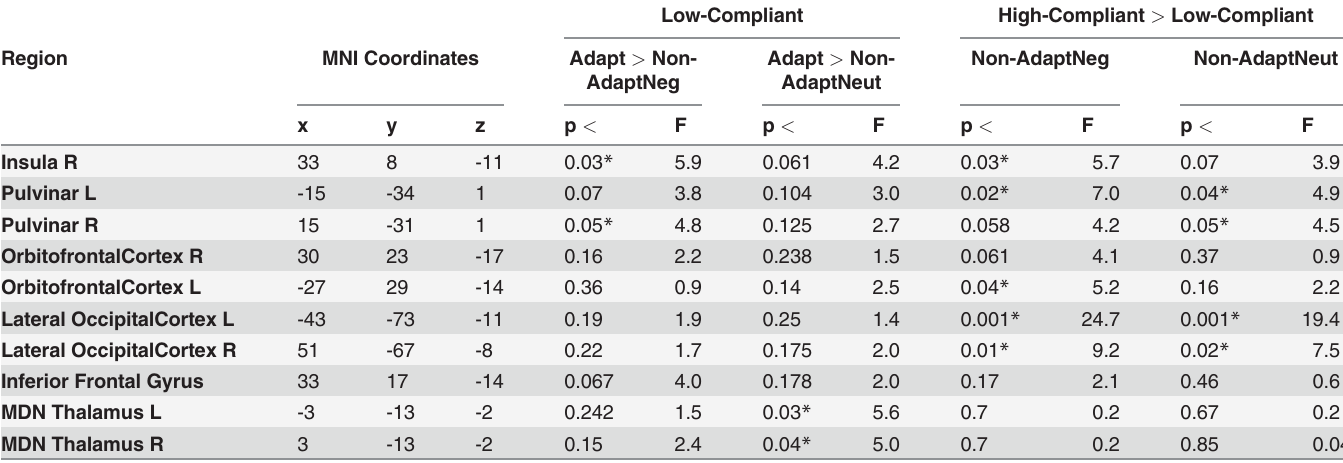
Table 2. Differences in effect sizes due to the adaptation of picture presentations in brain areas involved in emotional processing (ROIs taken from the main effect of emotions, see Fig. 6).